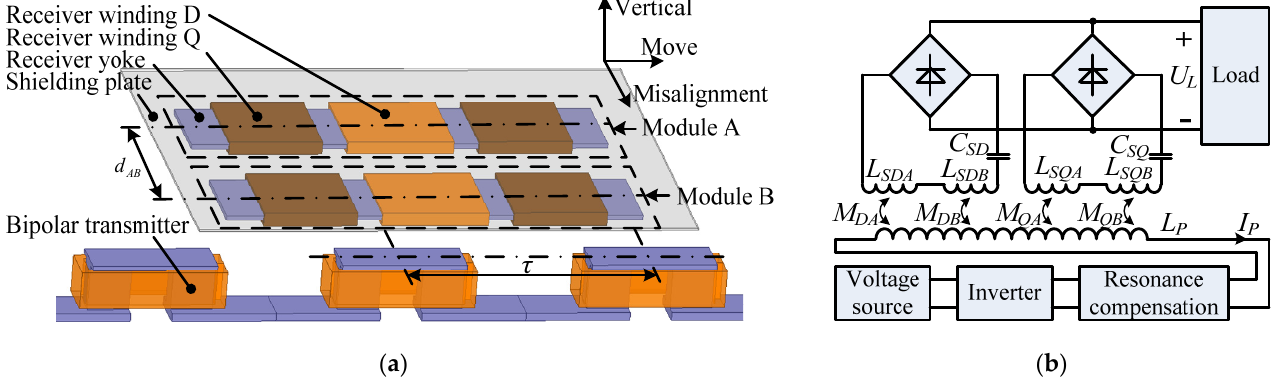
Figure 1. Overall configuration of the dual-phase NSP receiver: ( a ) Structure of the magnetic coupler with the dual-phase NSP receiver; ( b ) Connection of the dual-phase NSP receiver in the system.